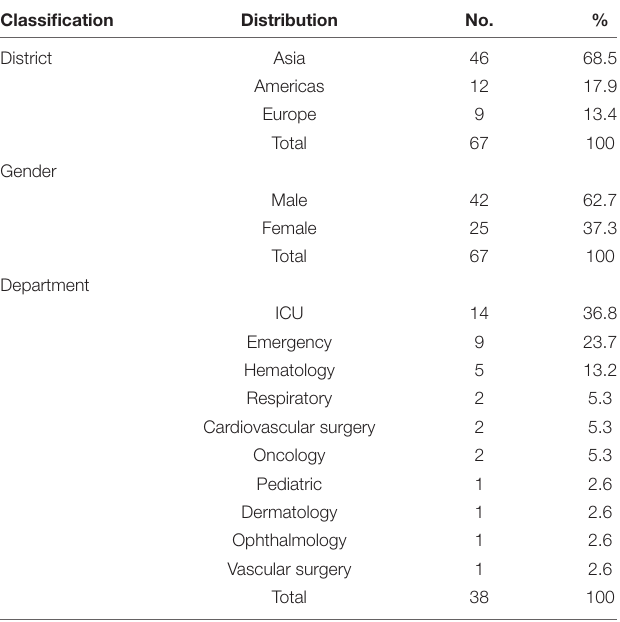
TABLE 1 | Epidemiological characteristics of K. ohmeri infection